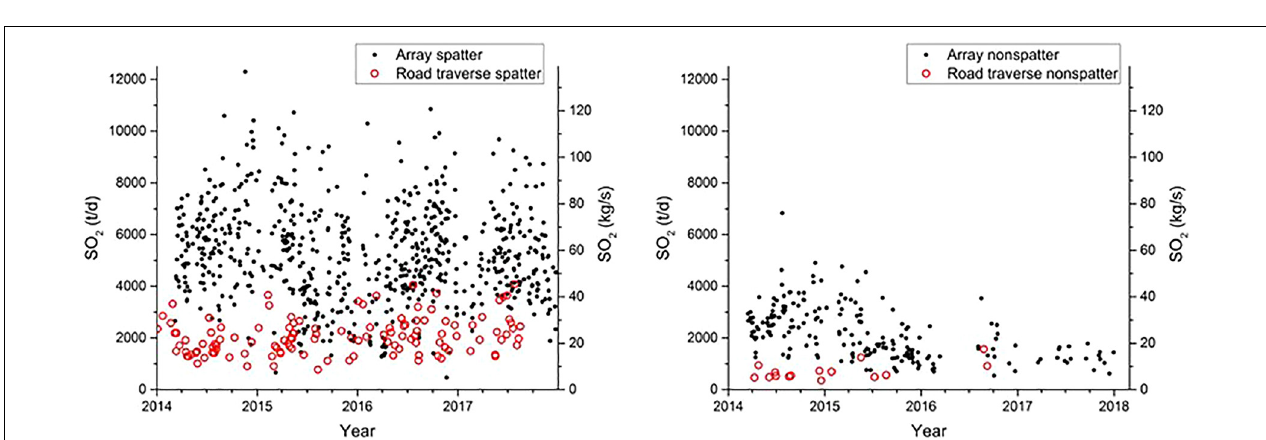
FIGURE 11 | Comparison of SO 2 emission rates from the FLYSPEC array (black dots) and the road- traverses (red bars) on March 30, 2017. The red bars indicate the range of values obtained from the various analysis methods described in section “Comparison of Different SO 2 Retrievals for Road Traverses.” A constant wind speed of 4.4 m/s was assumed in analyzing the traverse data, which corresponds to the average wind speed measured by the OBS anemometer during the measurement period.